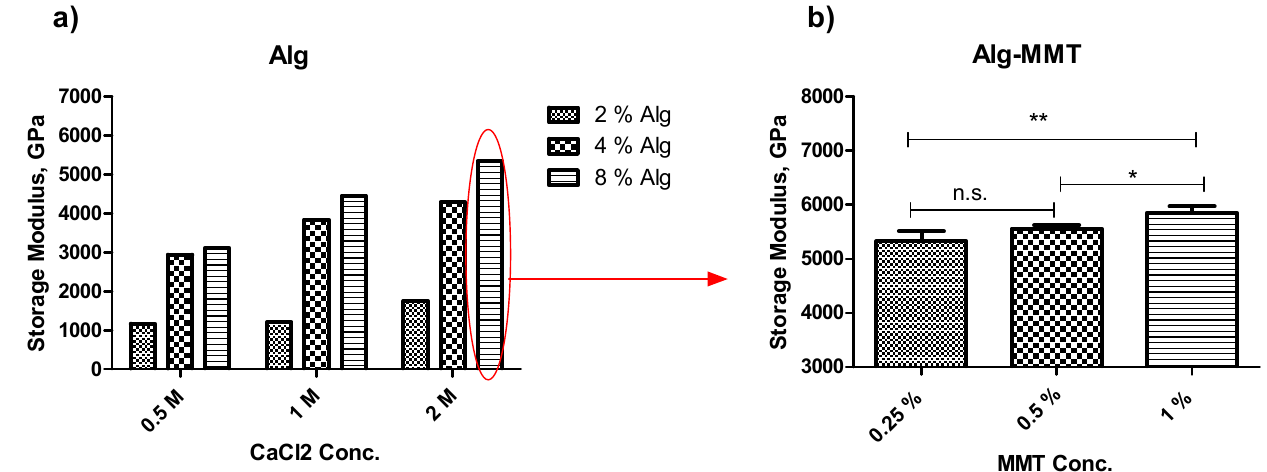
Figure 1. Optimization of component concentration. ( a ) Optimization of concentration of alginate and the cross-linker CaCl 2 ( n = 1). ( b ) Optimization of MMT concentration ( w/v ) in the capsule with optimized alginate and CaCl 2 concentration (red circled in Figure 2a) ( n = 3, ± SD). (Signs * and ** represents a significant difference < 0.05 and 0.01, respectively, and n.s. represents “not significant”.)